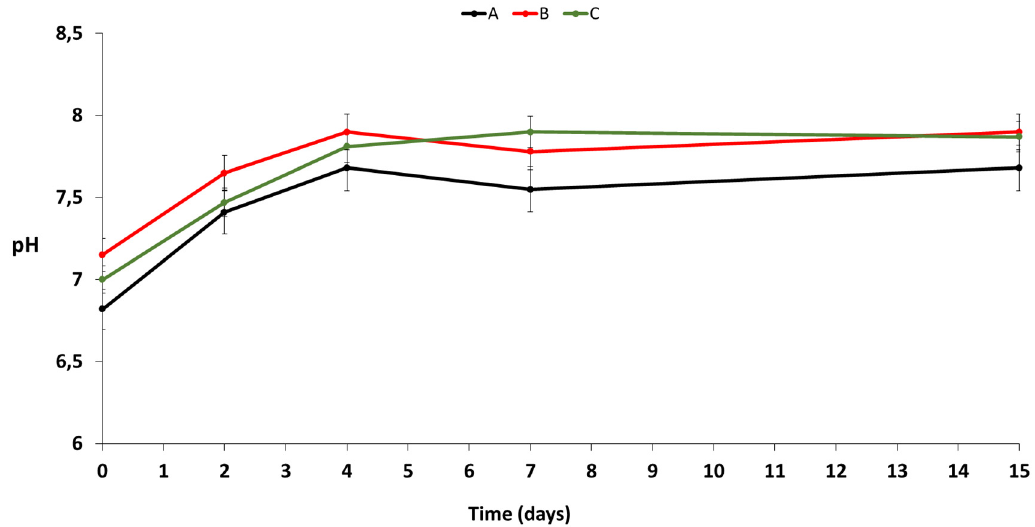
Figure 2. Evolution of the dissolved oxygen (top) and pH (bottom) of the three bioslurry experiments.